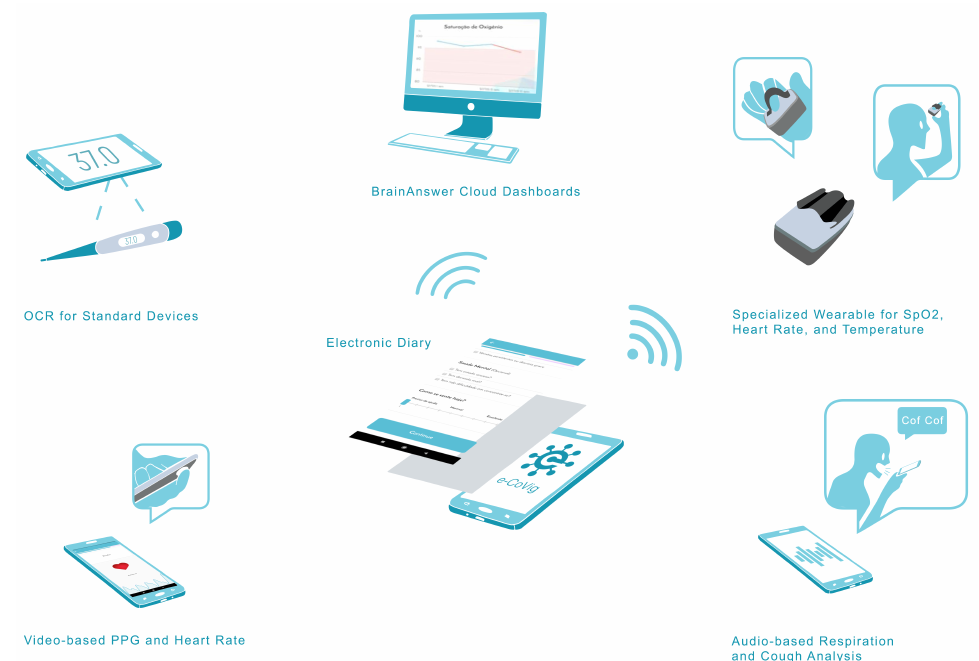
Figure 1. e-CoVig mHealth system